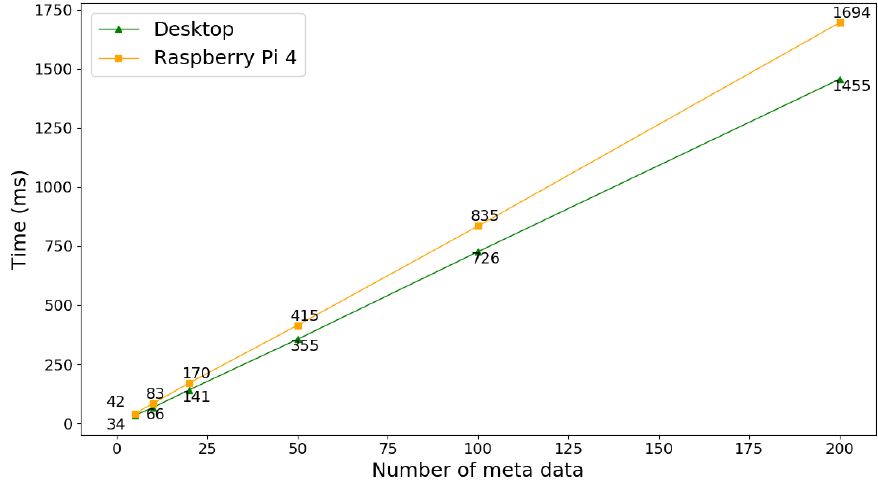
Figure 7. Processing time by meta-data verification on different